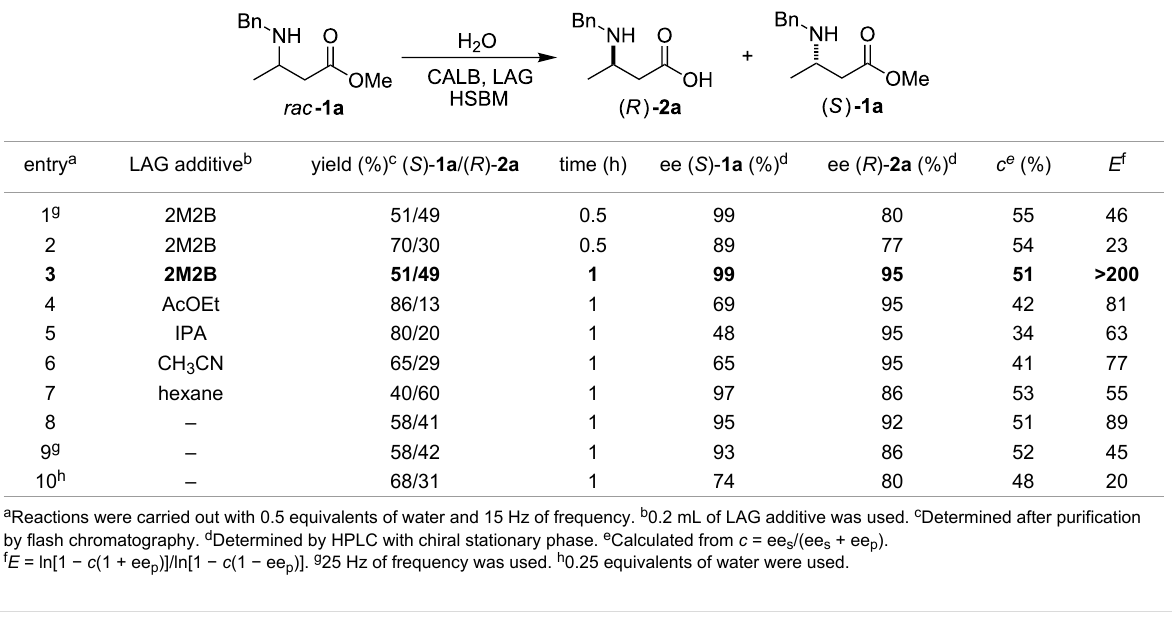
Table 2: Substrate scope for the enzymatic resolution of N -benzylated- β 3 -amino esters.